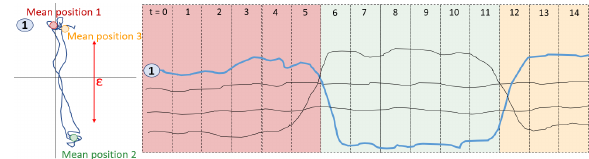
Figure 3. A sliding window-based detection method is applied to find intra-group position changes. Three resulting mean positions (left) indicate that object 1 (blue) changes its position twice.